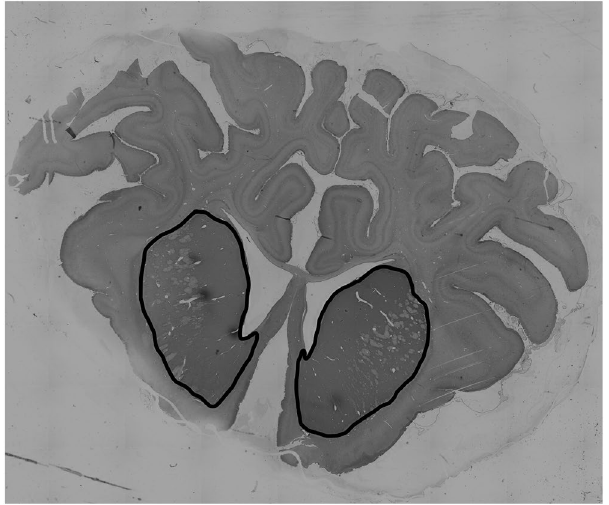
Figure 6. Photomicrograph showing the striatal area that was outlined at 2x and randomly sampled at 20x magnification, using a sampling grid set at 2200 × 2200. Striatal phenotypic neuronal populations were quantified from each hemisphere across 2